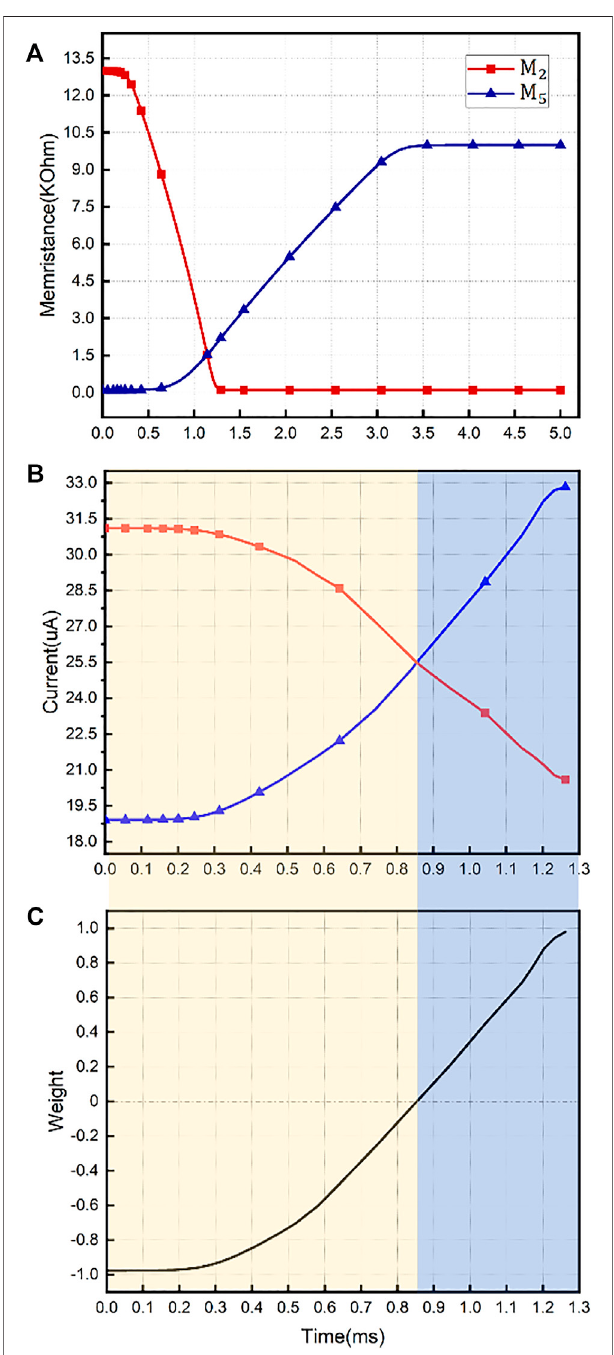
FIGURE 8 | (A) Memristance curve of M 2 and M 5 (B) Current i 4 , i 5 , and the weight (C) .